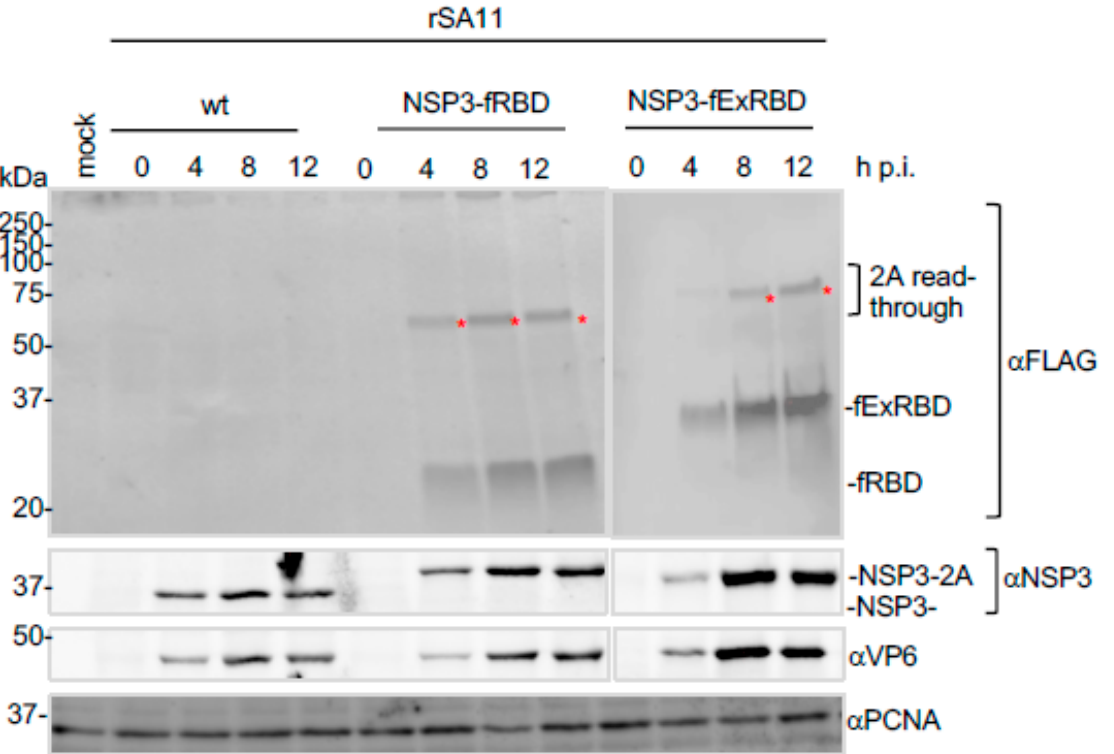
Figure 5. Production of RBD and ExRBD by rSA11 viruses during infection. MA104 cells were mock infected or infected with rSA11/wt, rSA11/NSP3-fRBD, or rSA11/NSP3-fExRBD (MOI of 5). Lysates were prepared from the cells at 0, 4, 8, or 12 h p.i. and analyzed by immunoblot assay using antibodies specific for FLAG, NSP3, VP6, and PCNA. Red asterisks (*) identify 2A read-through products. Positions of molecular weight markers are indicated (kDa).